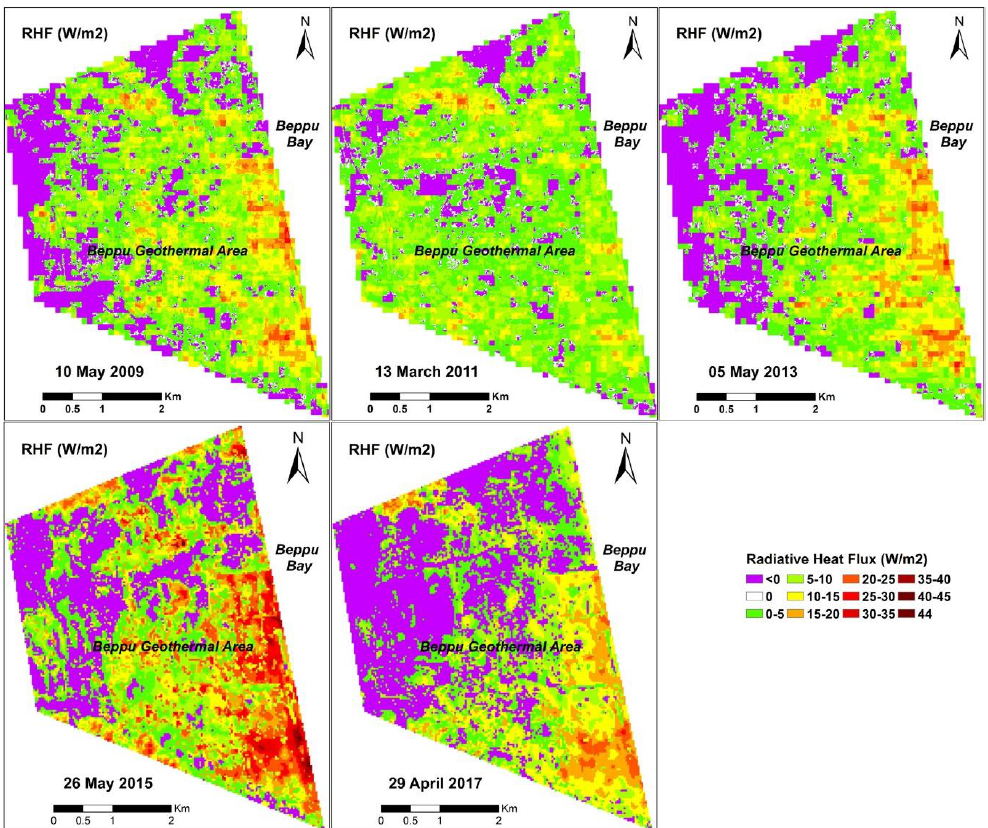
Figure 15. Radiative heat flux maps of the Beppu geothermal area, derived from nighttime ASTER thermal infrared data for 2009, 2011, and 2013 ( top row ), and derived from nighttime Landsat 8 TIRS data for 2015 and 2017 ( bottom row ).